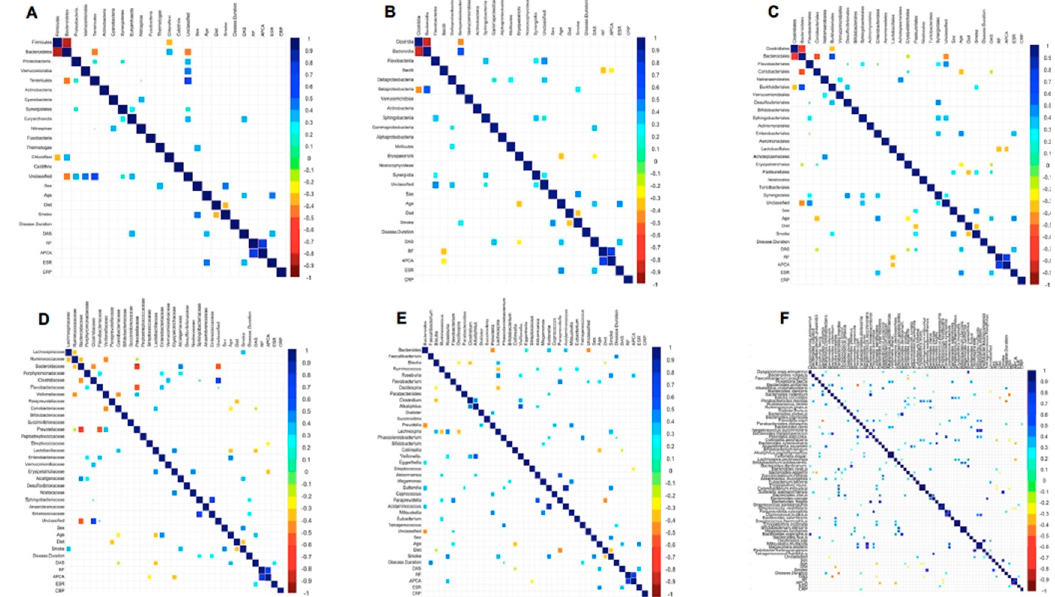
Figure 4. Association of gut microbiota profile with clinical pathological features in RA patients at the phylum ( A ), class ( B ), order ( C ), family ( D ), genus ( E ), and species ( F ) levels.